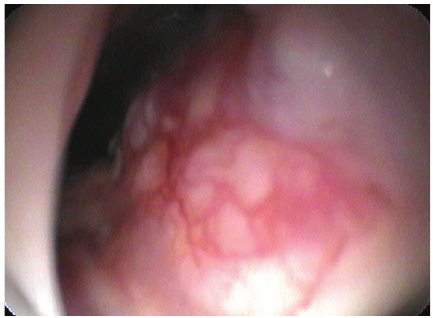
Figure 1: The proximal portion of the nodular tumor as seen on endoscopy of the esophagus. At time of this endoscopy, there was a severe stricture secondary to the tumor and a 6 mm scope was unable to be passed beyond it.